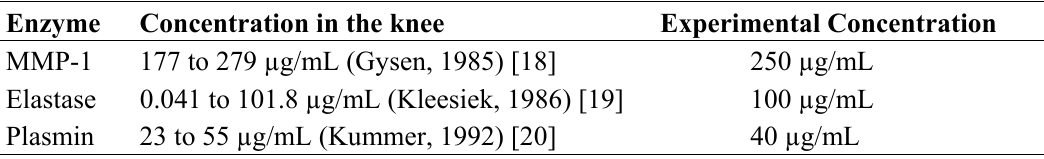
Table 1. Enzyme concentrations found in the synovial fluid of the knee and those used in this